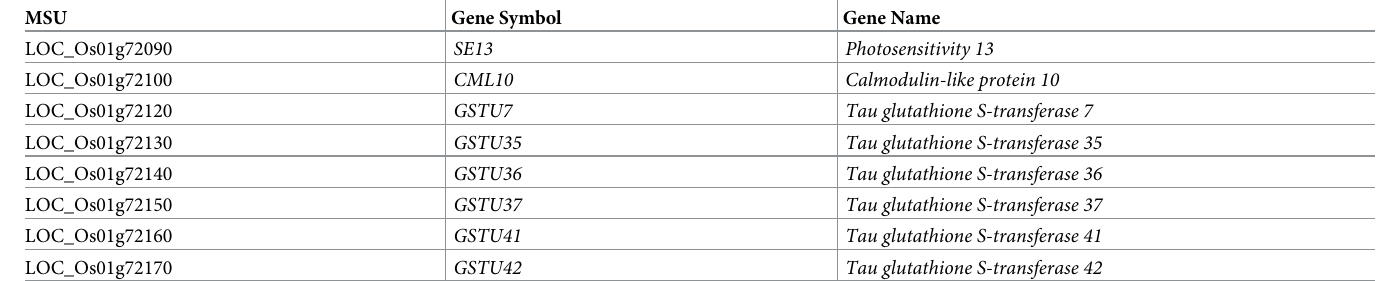
Table 6. Functional genes located in the deleted region in the G123 genome. Functional genes located between positions Chr1:414822688 and Chr1:41856061, corre- sponding to the deleted region in the G123